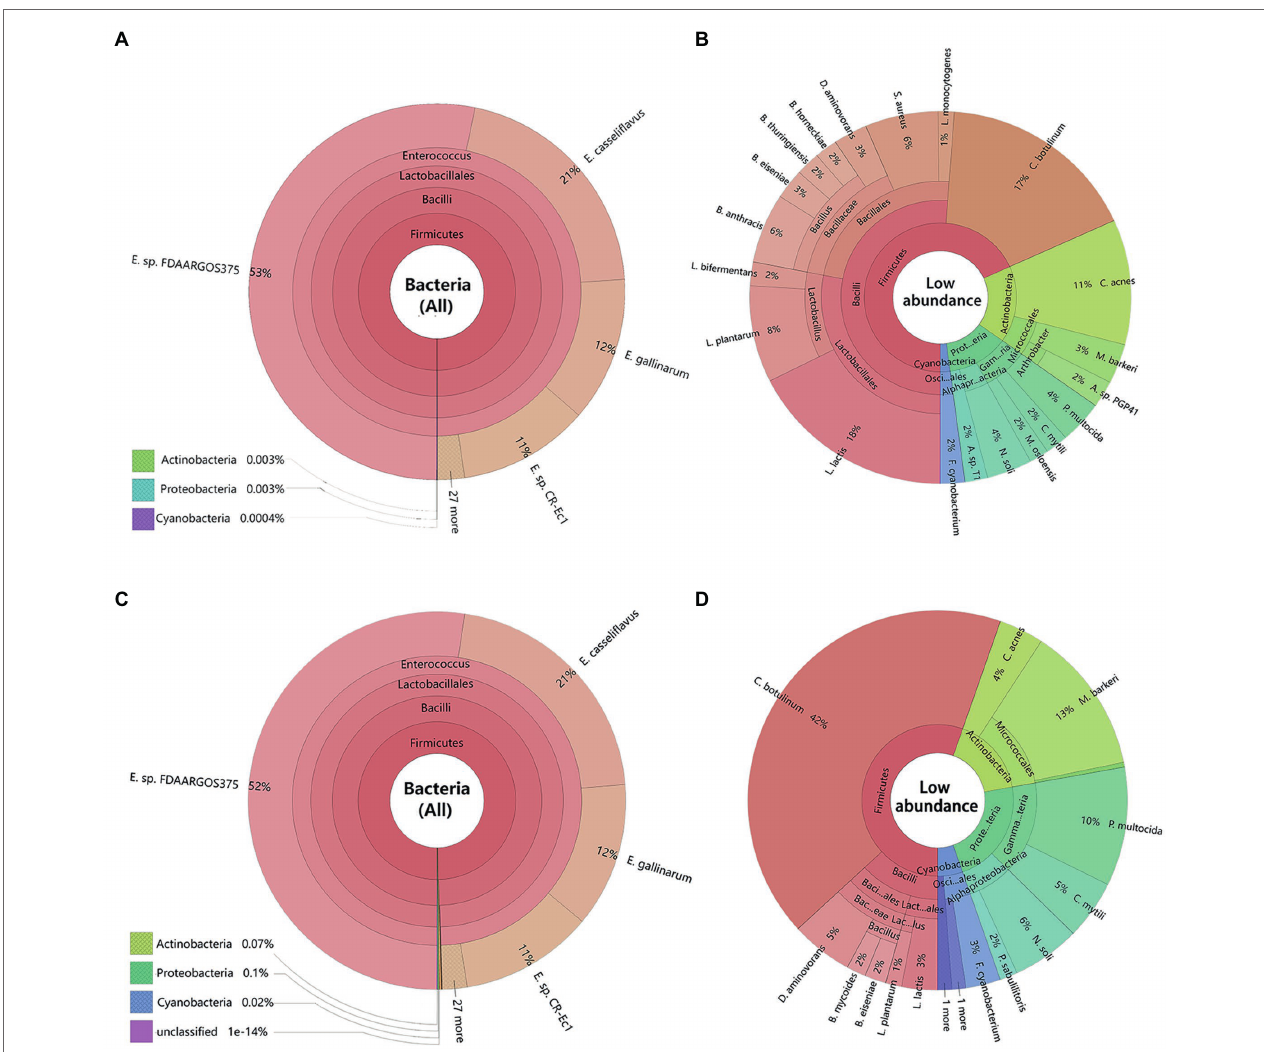
FIGURE 2 | Composition of bacteria in the larvae gut of Cnaphalocrocis medinalis based on metagenomic data. The species were annotated using Krona. Different classification levels were indicated as circles by inside and outside. (A) All species of C. medinalis gut bacteria feeding with rice; (B) Low abundance species without Enterococcus of C. medinalis gut bacteria feeding with rice; (C) All species of C. medinalis gut bacteria feeding with maize seedling; and (D) Low abundance species without Enterococcus of C. medinalis gut bacteria feeding with maize seedling. The following website also has dynamic and more detailed information about Krona: https://licm.github.io/krona/rice-maize.html and